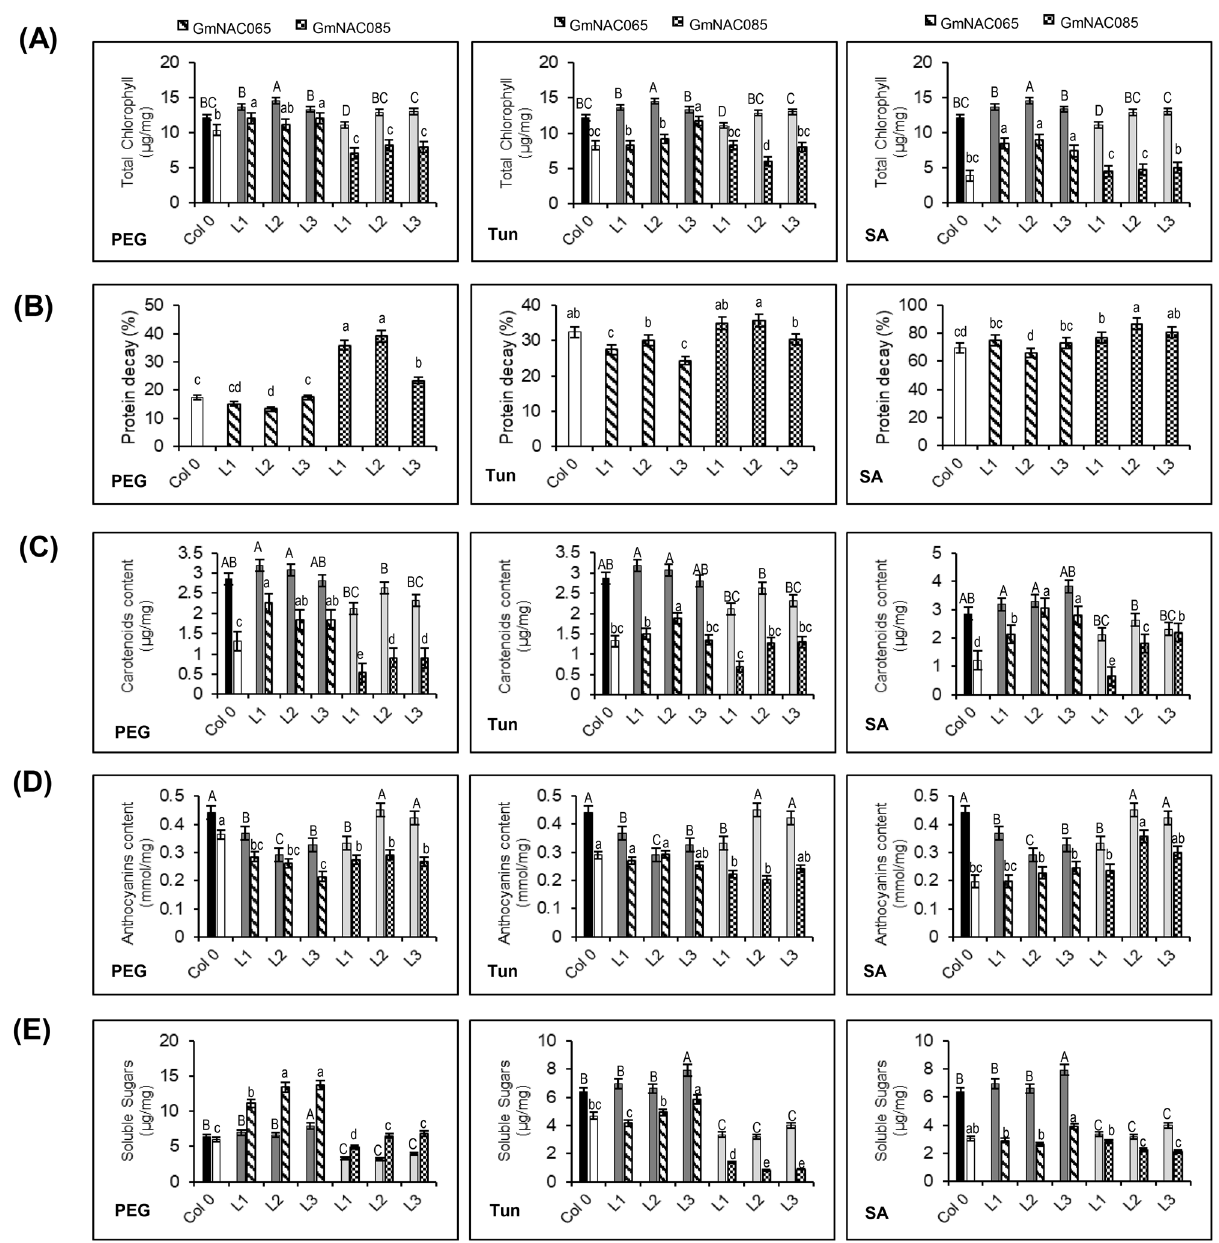
Figure 7. Metabolite content in transgenic Arabidopsis lines overexpressing GmNAC065 and GmNAC085 under different stress conditions. ( A ) Chlorophyll content. The chlorophyll content was accessed spectrophotometrically from ethanolic plant extracts. ( B ) Protein decay ratio. After stress, the protein decay ratio was calculated according to the total protein content, determined by the Bradford method. The protein content of untreated plants was considered 100% and the degradation ratio was expressed as the percentage of protein relative to the control. ( C ) Carotenoid content. The carotenoid content was determined spectrophotometrically from ethanolic plant extracts. ( D ) Anthocyanin content. Anthocyanin content was determined spectrophotometrically from ethanolic plant extracts. ( E ) Soluble sugar content was determined by the DNS-reducing method. Samples were subjected to the DNS reaction, and sugar concentration was determined based on a glucose standard curve. Drought, ER stress, and biotic stress were simulated by PEG 8000—10% w/v; Tun—5 µg/mL; and SA—75 µM treatments for 24 h, respectively. Solid bars show data from untreated plants. Upper bars indicate standard error (95% of confidence). Uppercase letters indicate significant differences among control samples, and lowercase letters indicate significant differences among the treated samples by the Tukey’s test (p < 0.05, n =